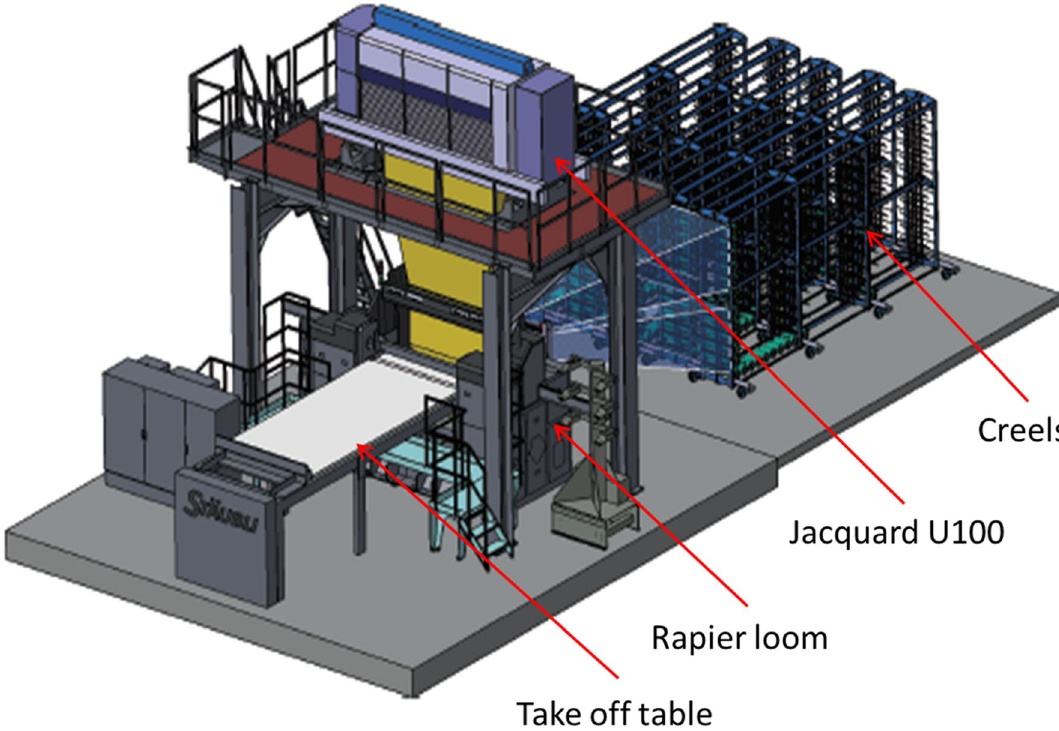
Figure 5. A schematic of the 3D weaving system.